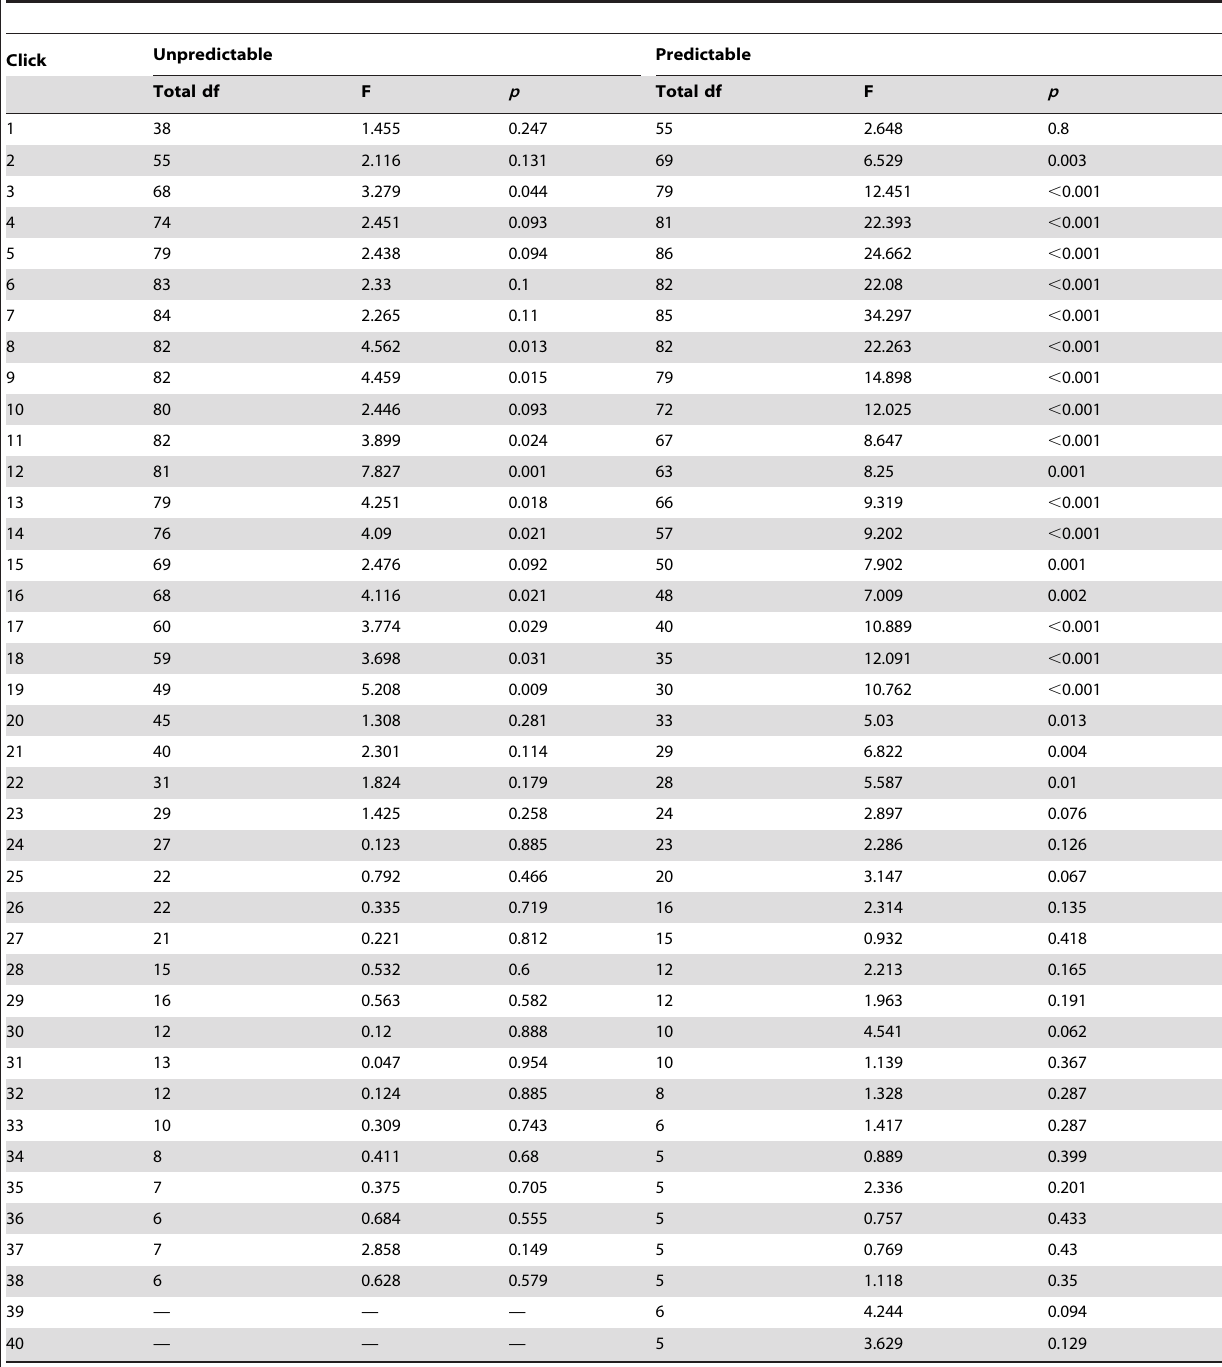
Table 2. Summary statistics of one-way ANOVA for all the clicks produced by the dolphin for the unpredictable and predictable